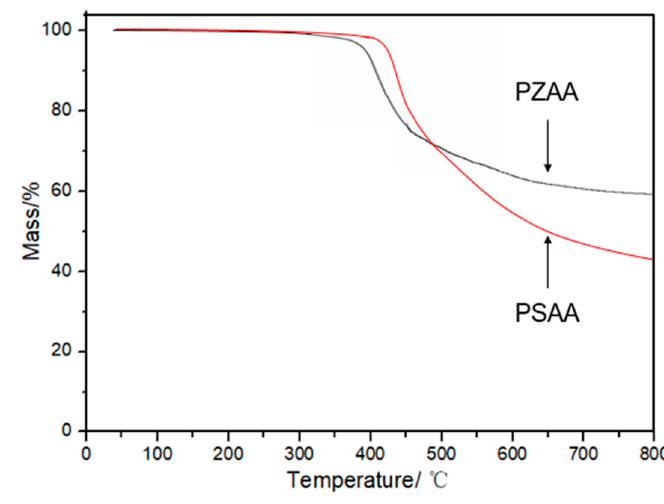
Figure 7. TGA curves of PSAA and PZAA in air. Table 2. TGA analysis results of BA and BSA in air.